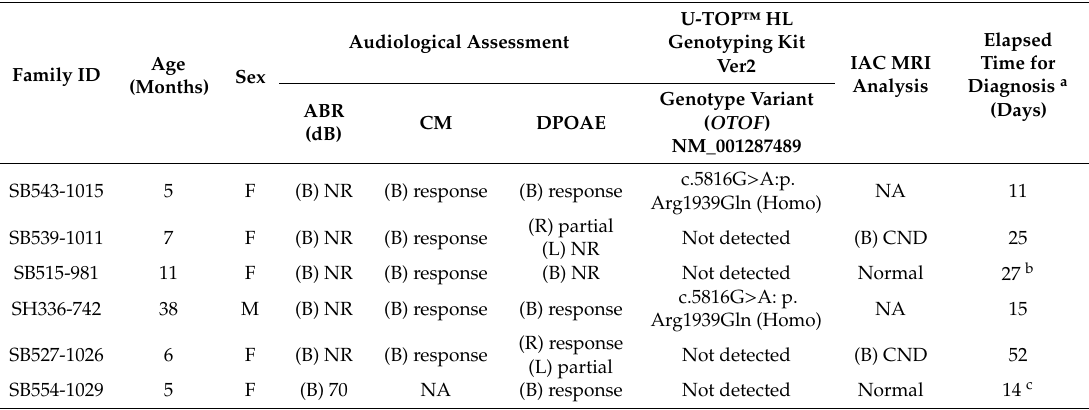
Table 2. Phenotypic spectrum and etiologic diagnosis of six consecutive additional subjects with prelingual auditory neuropathy spectrum disorder